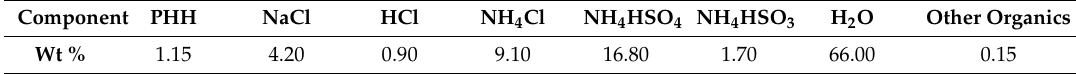
Table 1. Chemical components of the